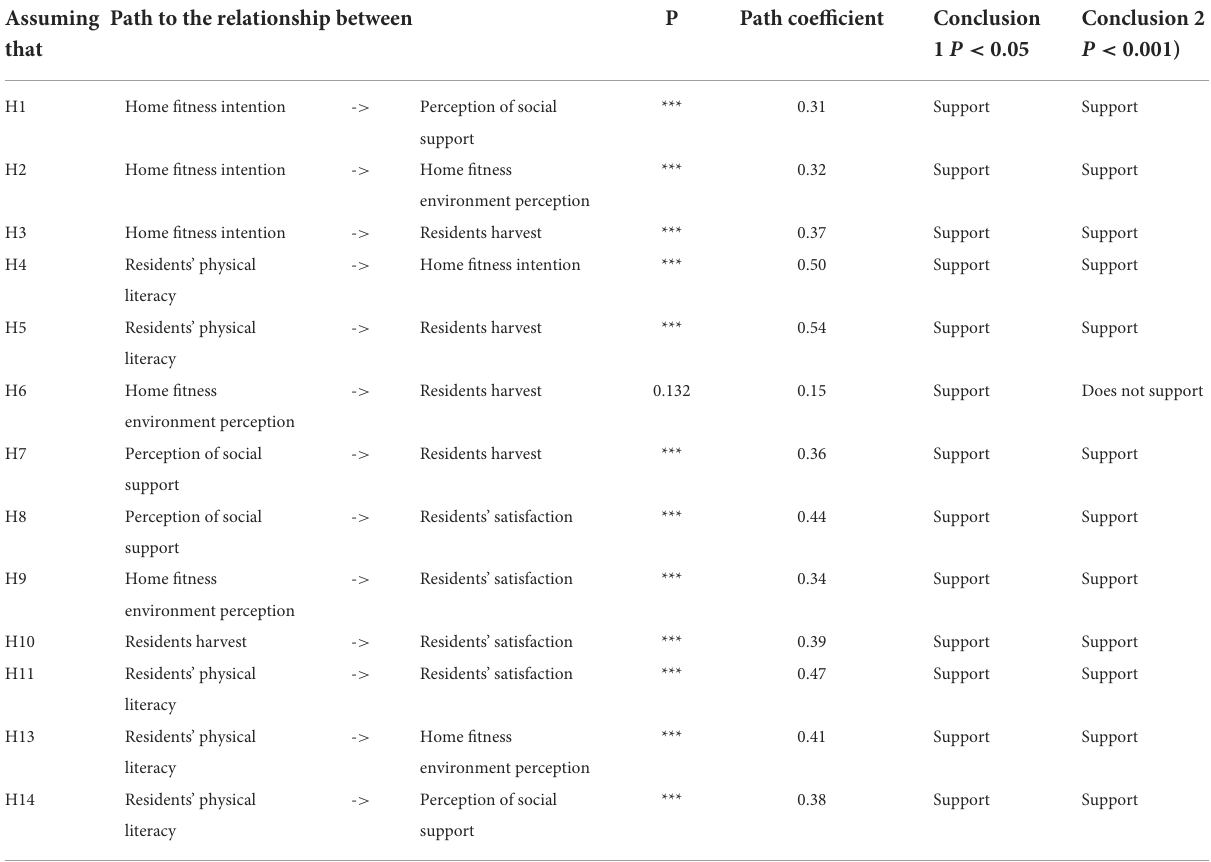
TABLE 10 Test of significance of path coefficient of model structure variables.